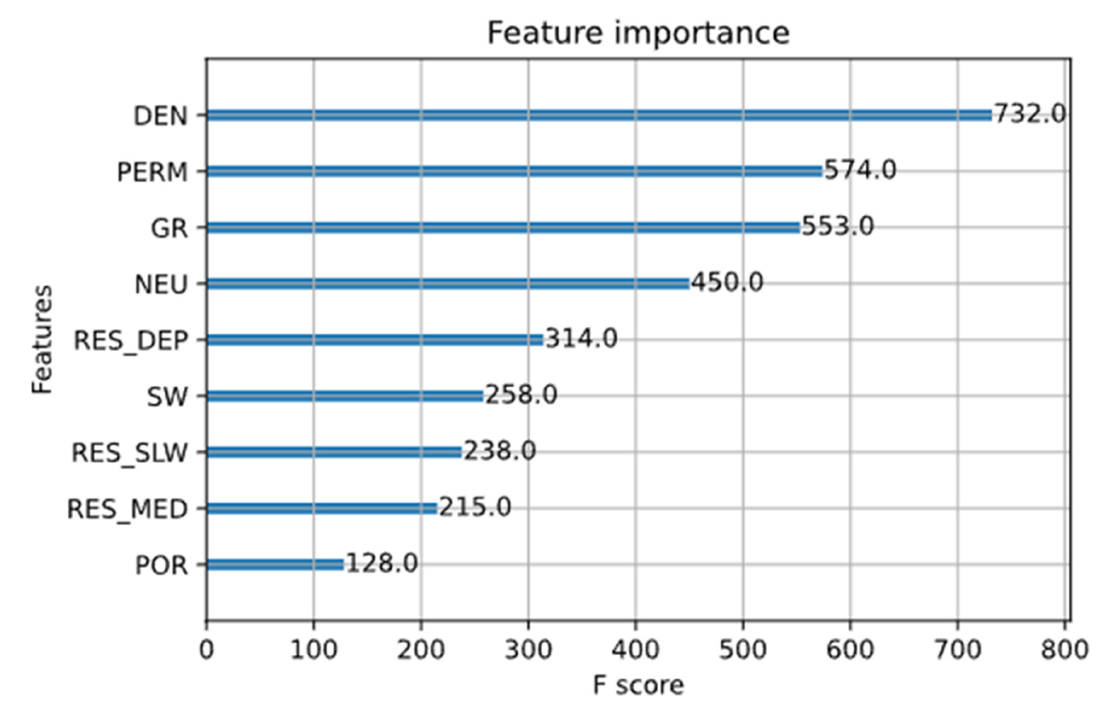
Figure 11. XGBoost feature importance in predicting NMR T2LM.